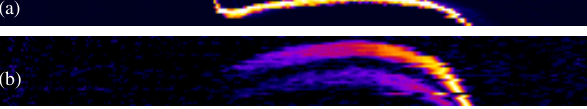
FIG. 11. (Color) (a) Intensity plot of K (cid:1) ion signal during the beam pulse as a function of time. The vertical size of this image is 12.6 keV in beam energy. (b) Intensity plot of K (cid:1)(cid:1) ion signal during the beam pulse. The hole plate is biased to (cid:1) 9 : 4 kV . Note the two curves indicating ions from the hole plate (upper curve) and from the entrance slit (lower curve) are cut off before the end of the beam pulse because the analyzer voltage scan ends at that point. The vertical size of this image is 25.2 keV in beam